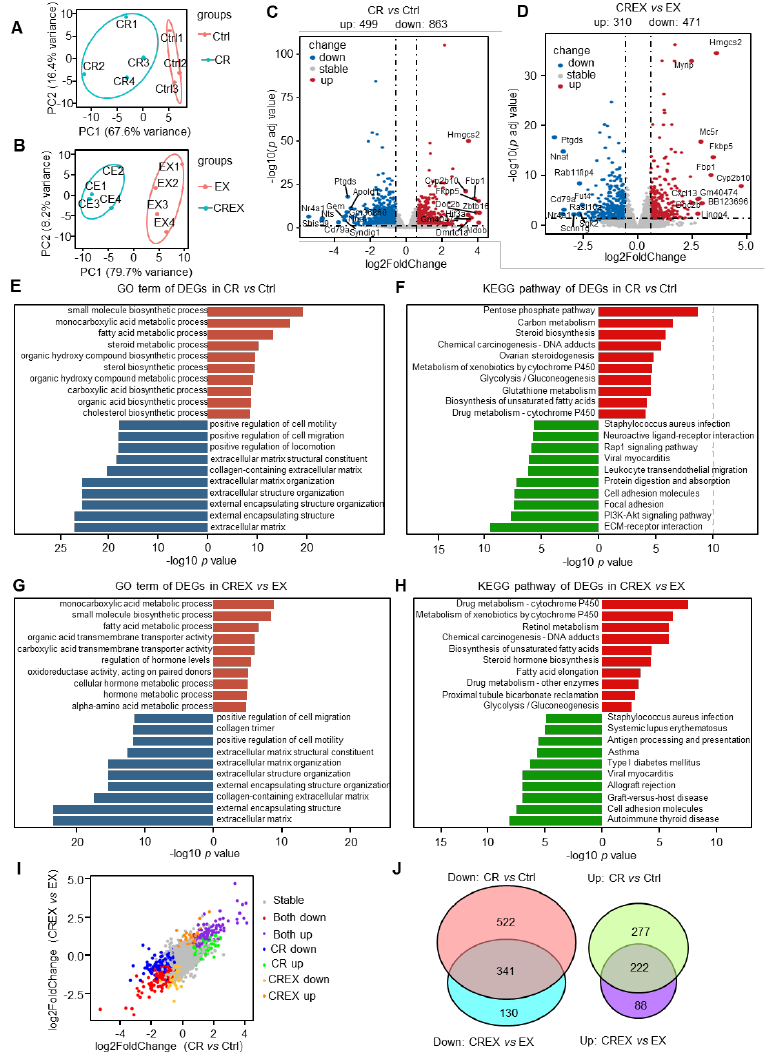
Figure 2. Transcriptomic changes in BAT upon CR with or without EX. ( A , B ) Principal component analysis plot of the BAT samples in the control and CR groups ( A ) and in the EX and CREX groups ( B ). ( C , D ) Volcano plots of DEGs in the CR vs. control groups ( C ) and in the CREX vs. EX groups ( D ). The top 20 genes with the highest absolute values for the log2FC were labeled (down: p < 0.05 and log2FC < −0.58; up: p < 0.05 and log2FC > 0.58). ( E ) Enriched GO terms for all DEGs in BAT upon CR. ( F ) Enriched KEGG pathways for all DEGs in BAT upon CR. ( G ) Enriched GO terms for all DEGs in BAT upon CREX. ( H ) Enriched KEGG pathways for all DEGs in BAT upon CREX. ( I ) Dot plot of genes’ log2FC in CR vs. control groups and CREX vs. EX groups. Stable, genes that were not differently expressed in the CR vs. control groups or CREX vs. EX groups; Both down, downregulated DEGS across the two comparisons; Both up, upregulated DEGS across the two comparisons; CR down, specific downregulated DEGS in the comparison between the CR and control groups; CR up, upregulated DEGS in the comparison between the CR and control groups; CREX down, specific downregulated DEGS in the comparison between the CREX and EX groups; CREX up, upregulated DEGS in the comparison between the CREX and EX groups. ( J ) Venn plot of common and distinct DEGs upon CR with or without EX. Brick red, enriched GO terms for upregulated DEGs; navy blue, enriched GO terms for downregulated DEGs; bright red, enriched KEGG pathways for upregulated DEGs; green, enriched KEGG pathways for downregulated